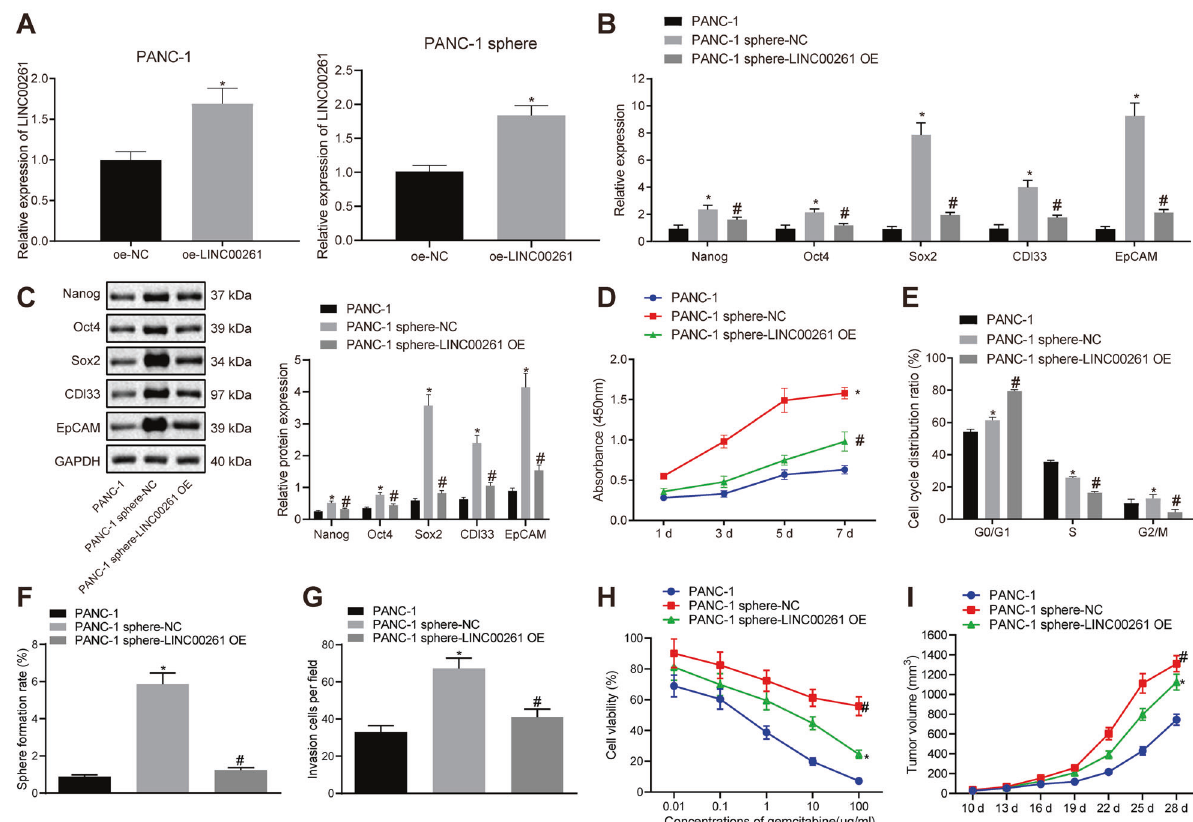
Fig. 3 Upregulation of LINC00261 suppresses the proliferation, self-renewal, invasion and tumorigenicity while enhances the sensitivity for gemcitabine in PANC-1 cells and stem cells. A Transfection ef fi ciency of LINC00261 overexpression in PANC-1 cells and stem cells determined by RT-qPCR. B Expression of stem cell markers in PANC-1 cells, the oe-NC group, and the oe-LINC00261 group determined by RT- qPCR. C The protein levels of stem cell markers in PANC-1 cell and stem cells measured using western blot analysis. D Cell proliferation of PANC-1 stem cell in PANC-1 cells, the oe-NC group, and the oe-LINC00261 group examined by CCK-8 assay. E Cell cycle distribution of PANC-1 cells and stem cells overexpressing LINC00261 examined by fl ow cytometry. F Cell sphere formation ability of PANC-1 cells and stem cells overexpressing LINC00261. G Invasion of PANC-1 cells and stem cells overexpressing LINC00261 assessed by Transwell assay. H Cytotoxicity of PANC-1 cells and stem cells overexpressing LINC00261. I Tumor volume in nude mice bearing PANC-1 cells and stem cells overexpressing LINC00261. * p < 0.05 vs. the oe-NC group in panel A or PANC-1 cells in panels B-I. # p < 0.05 vs. PANC-1 stem cells. Each experiment was repeated three times and measurement data were expressed as mean ± standard deviation. Comparisons between two groups were analyzed by independent sample t test, comparisons of data and different time point were analyzed by repeated measures ANOVA followed by Bonferroni post hoc test, and comparisons among multiple groups were analyzed by one-way ANOVA, followed by Tukey ’ s post hoc test. CCK- 8 cell counting